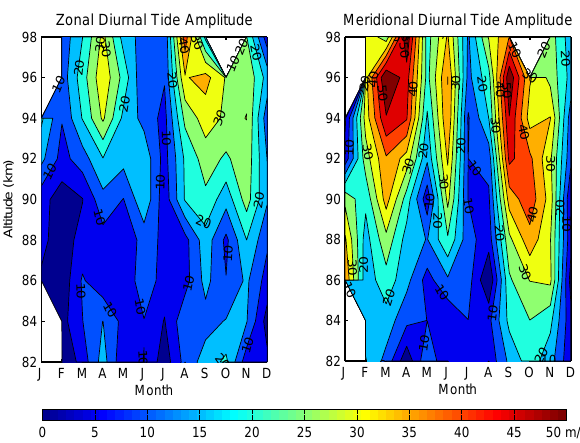
Fig. 6a. Twelve month contour plots of diurnal amplitude for zonal (left) and meridional (right) components.